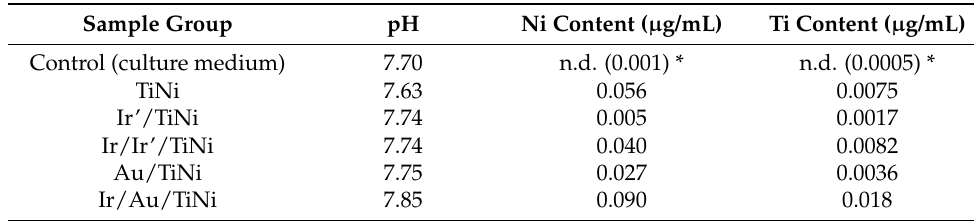
Table 3. Characteristics of the extracts obtained by keeping the bare TiNi samples and those coated with noble metal films in the culture